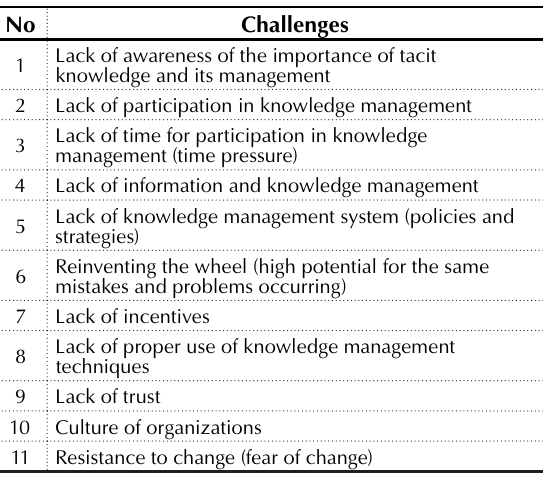
Table 2. KM challenges within the TPS